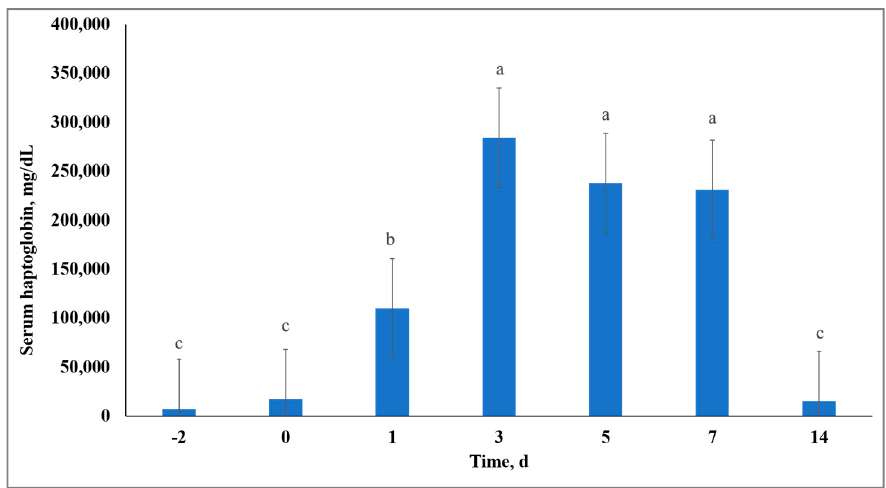
Figure 3. Effect of day on serum haptoglobin (Hp) concentration. Serum Hp concentration (day effect;